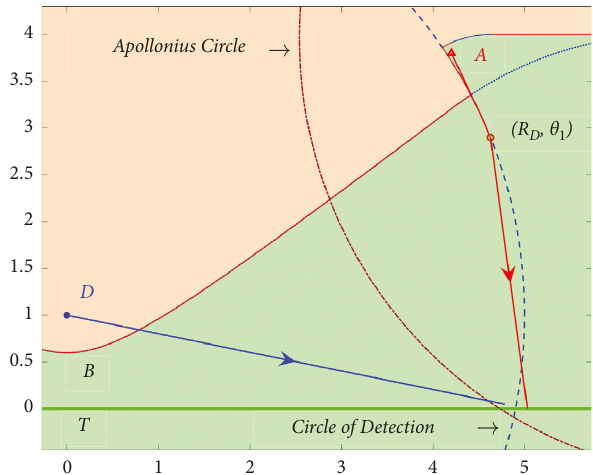
Figure 15: The numerical simulation of the barrier related to equation (62).